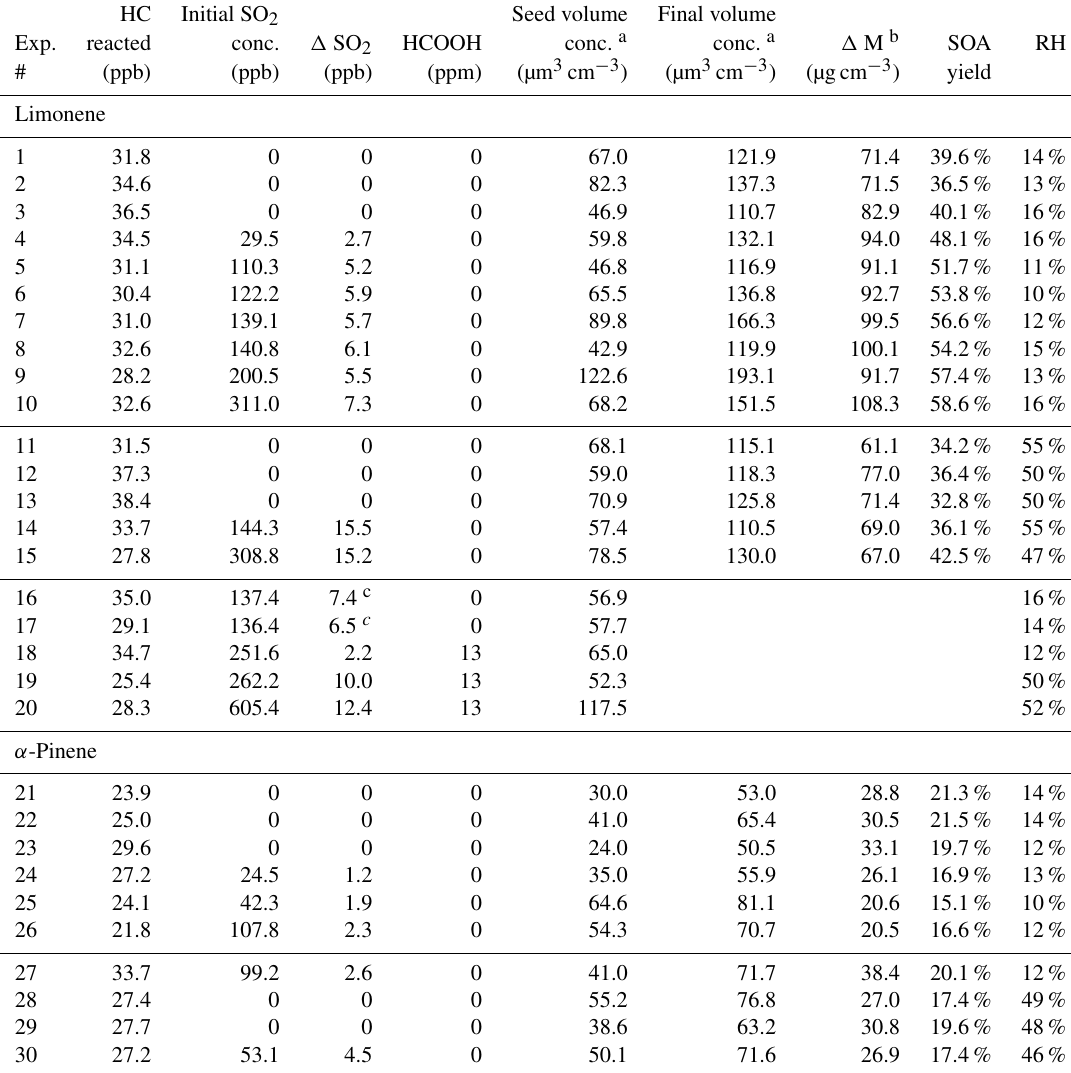
Table 1. Summary of conditions and results for limonene and α -pinene SOA experiments. HC Initial SO 2 Seed volume Final volume Exp. reacted